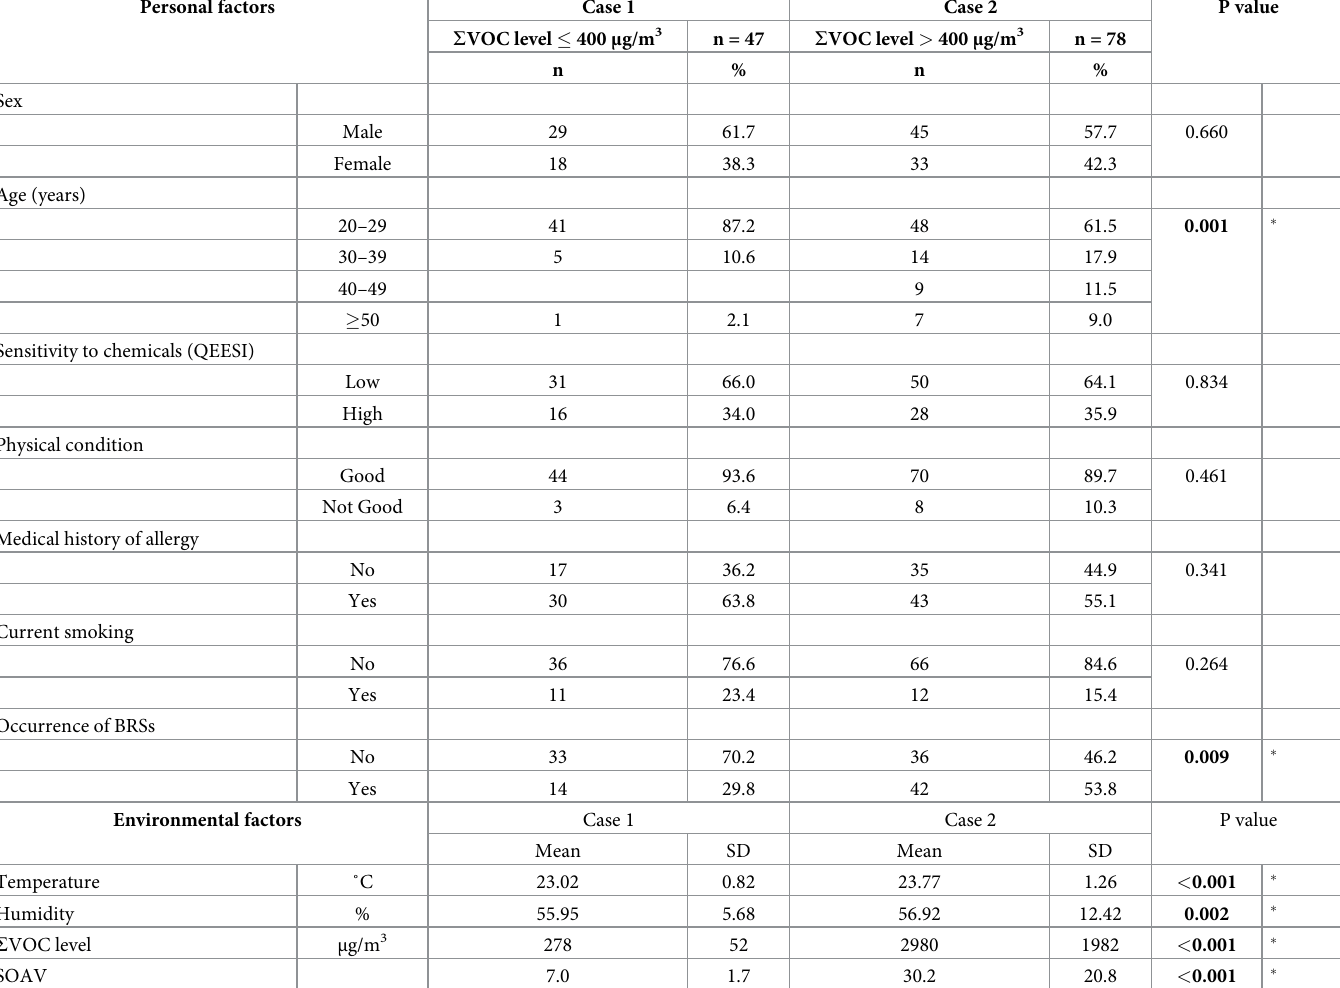
Table 1. Characteristics of participants and indoor environment